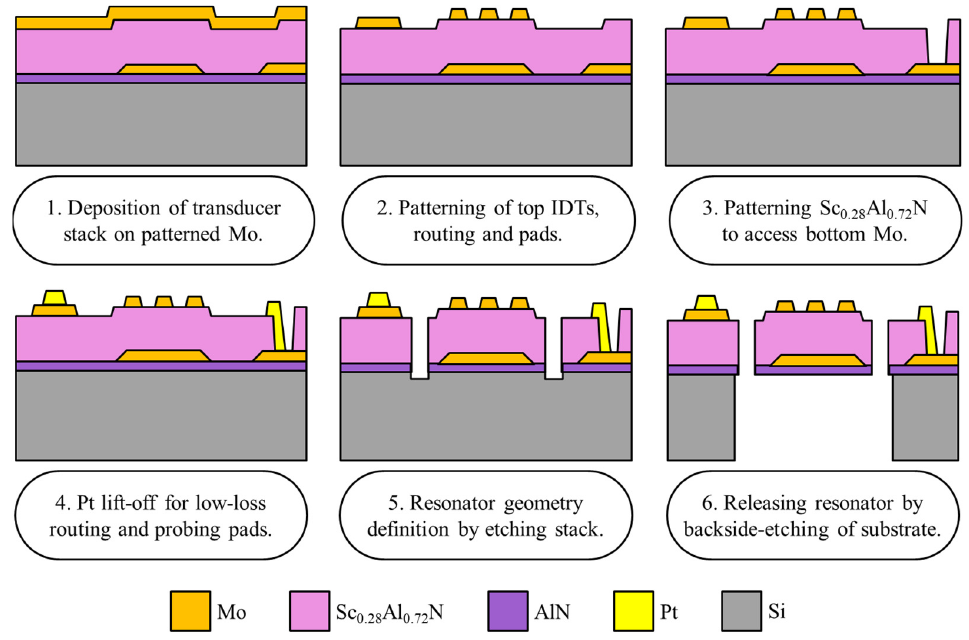
Figure 3. Fabrication process flow of Sc 0.28 Al 0.72 N Lamb-wave resonators.